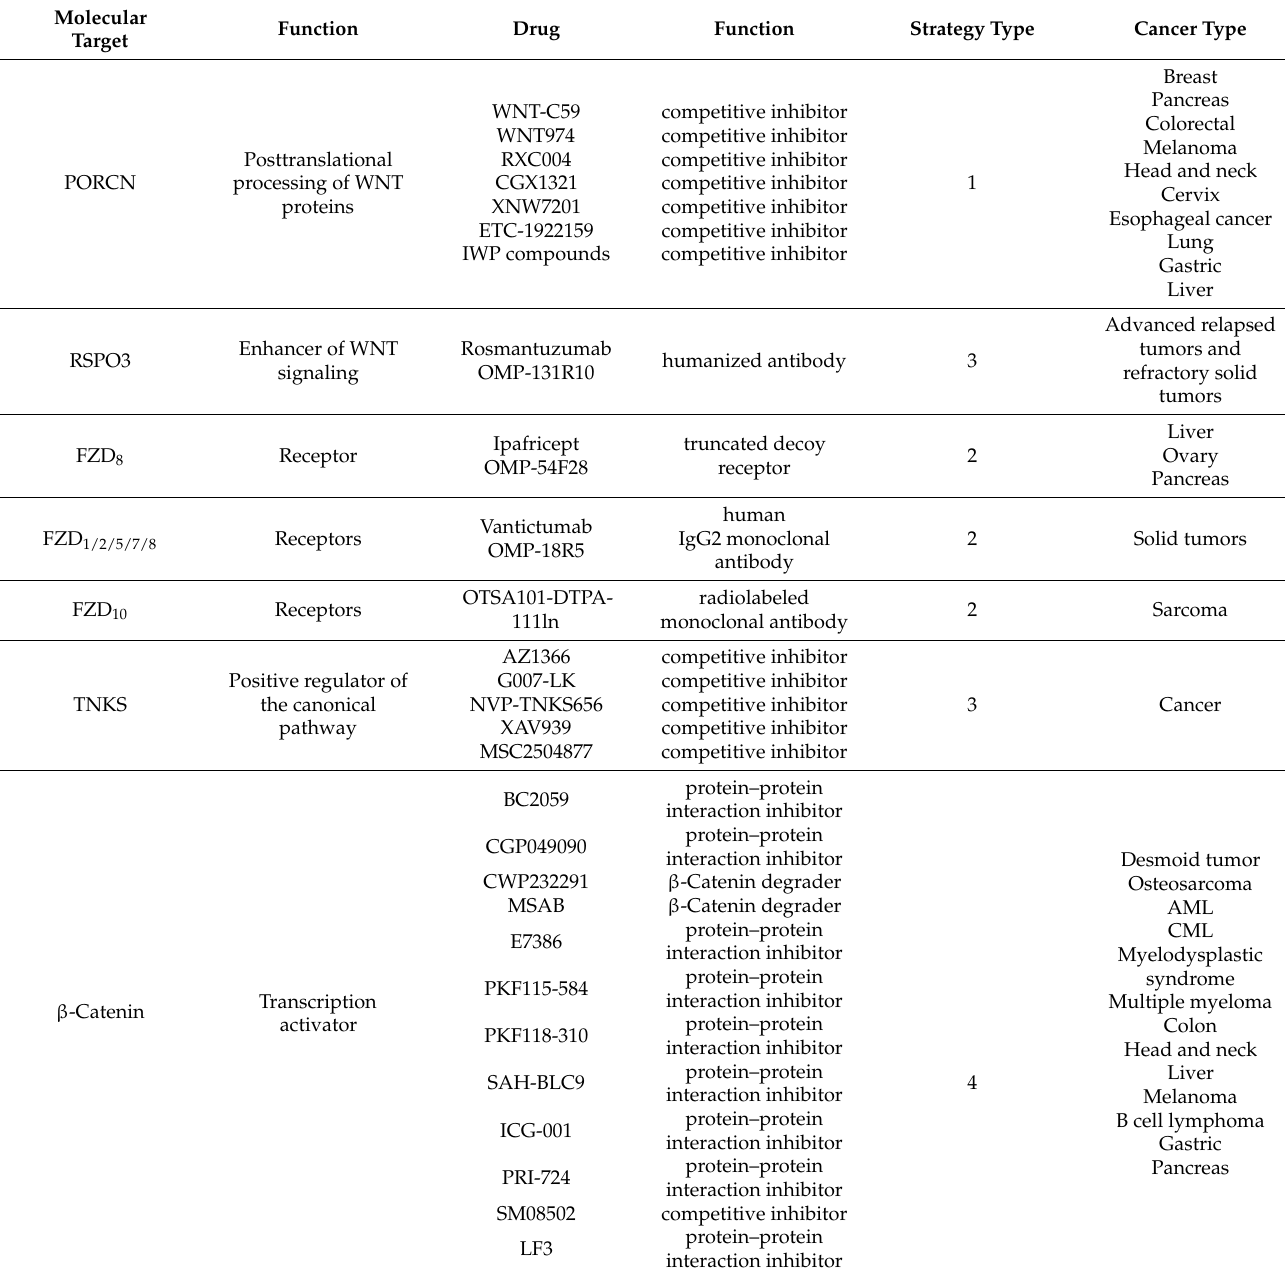
Table 1. WNT pathway modulators in clinical trials. Adapted from